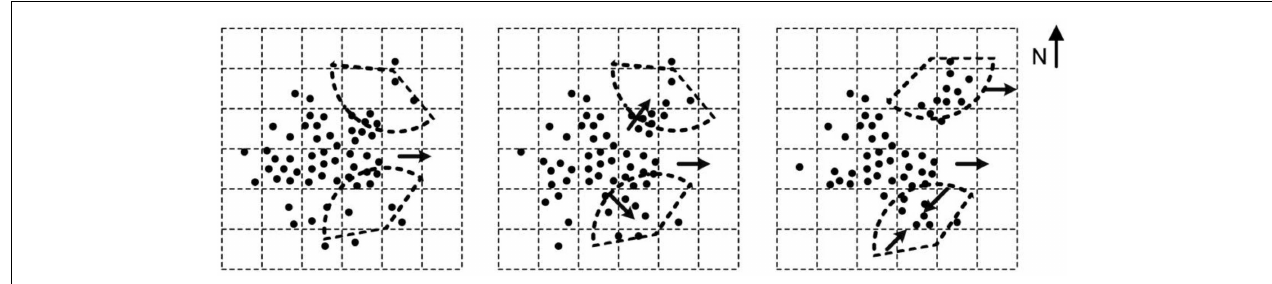
FIGURE 7 | Simulated motion patterns . Dots: individuals in simulation case study. Arrows: crowd moving directions. Dashed sectors: UGVs’ detection ranges.